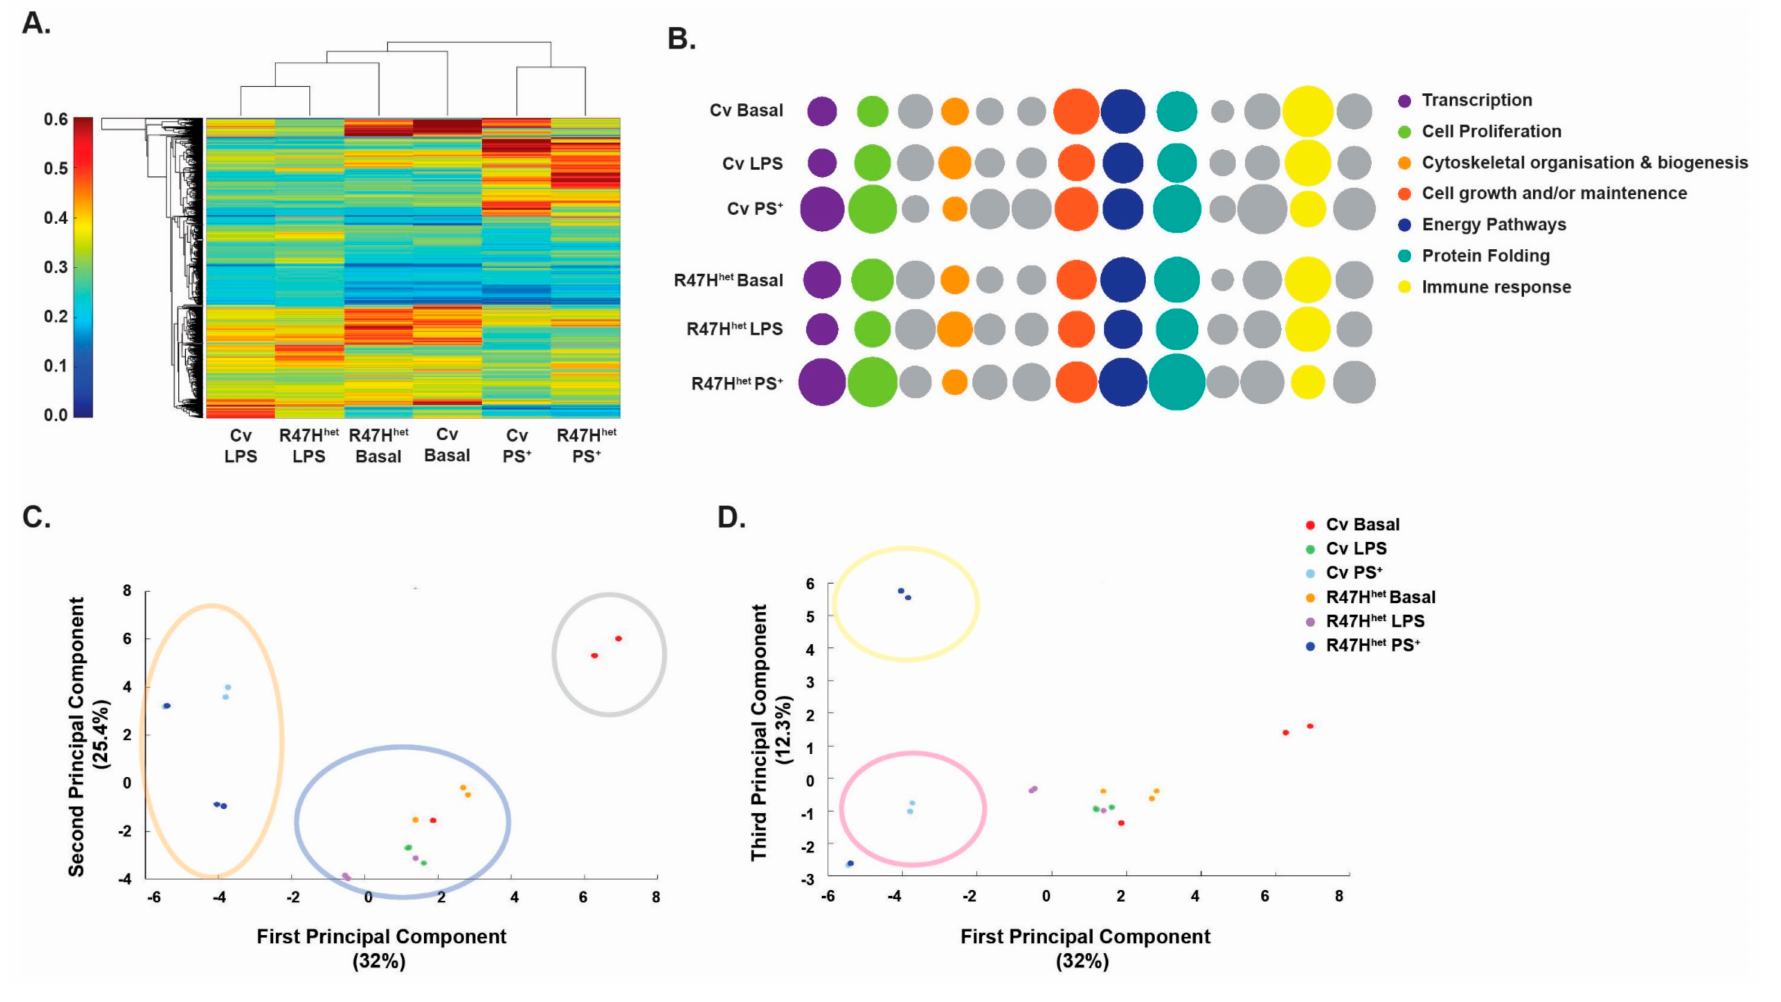
Figure 1. Following treatment, exosomes fell into specific clusters. Following the LC-MS/MS process, a heatmap of the exosomal proteins was constructed to analyse the effect of the different iPS-Mg treatments on exosomal proteome content ( A ). The relative abundance of proteins associated with different biological processes, identified with FunRich, was plotted for the different conditions, with the diameter of the circles representing protein abundance ( B ). Principal component analysis (PCA) was used to find clusters between the different samples ( C , D ). N = 3 independent samples analysed by LC-MS/MS for each